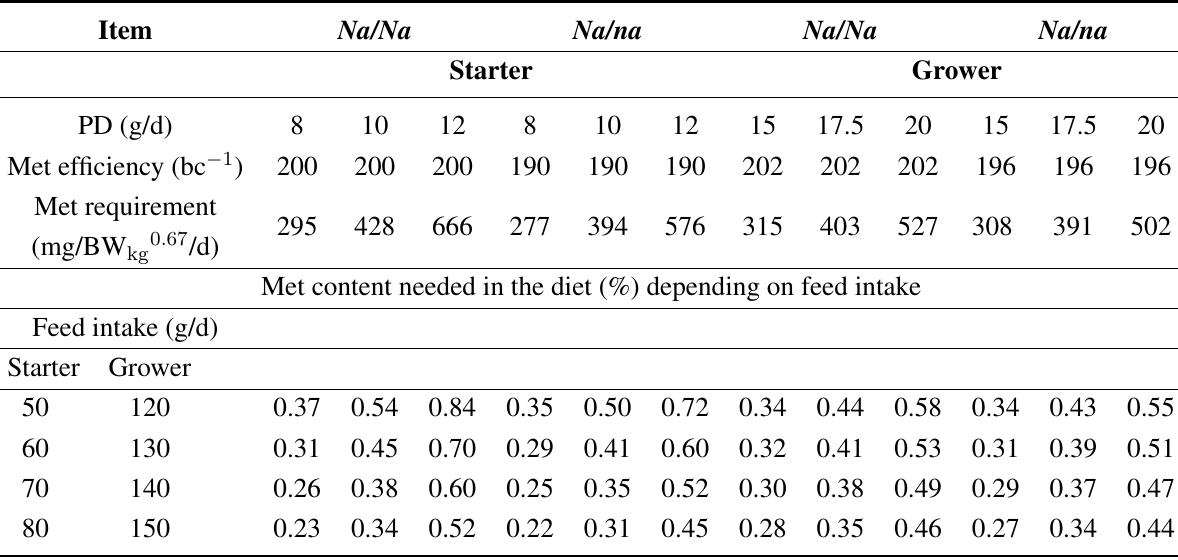
Table 4. Modeling of Met requirement data for male naked neck ( Na/Na ; Na/na ) meat type chicken in starter and grower periods, depending on daily body protein deposition (PD) and